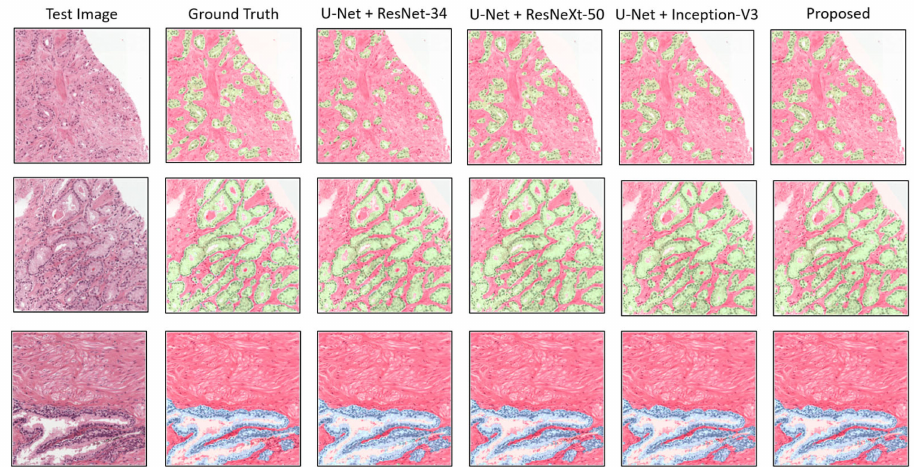
Figure 7. Comparison of segmentation examples from the proposed model with existing methods. Red, blue, and green colors signify stroma, benign, and cancer regions, respectively. The size of each tile in test set is the same as the train dataset, which is 256 × 256 pixels at 0.5 µ